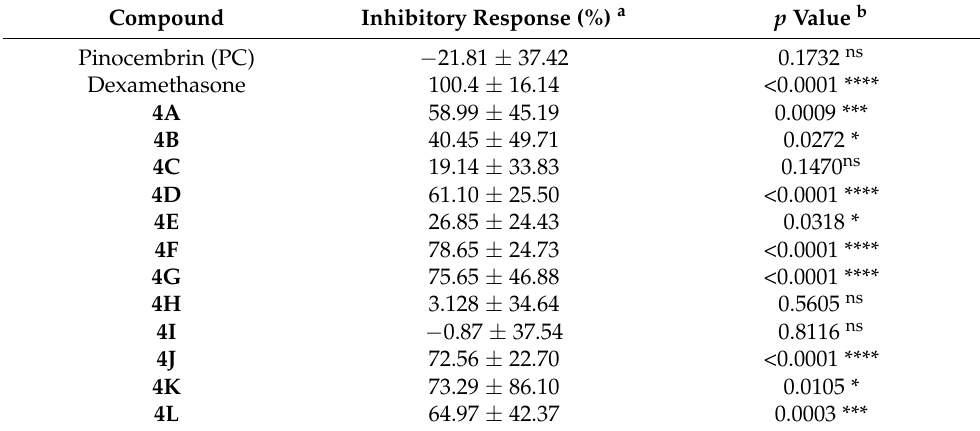
Table 2. Inhibitory effect of analogues 4A – L on LPS-induced NO production by RAW264.7. Compound